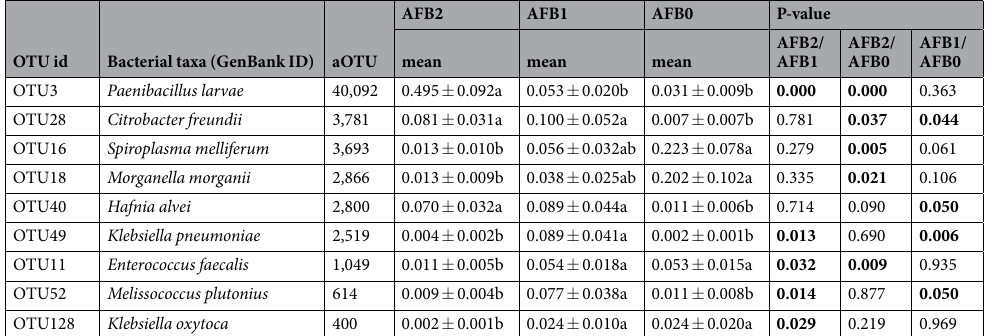
Table 1. METASTATS analysis results of the relative abundance of the environmental/pathogenic bacteria (cut- off microbiome). Samples of honeybee colonies with (AFB2) and without (AFB1) clinical symptoms from AFB apiaries and control (AFB0) samples outside the AFB zone were compared. Statistical differences are indicated by letters and marked in gray. Significant differences are indicated by P-values ( α < 0.05) and are marked in